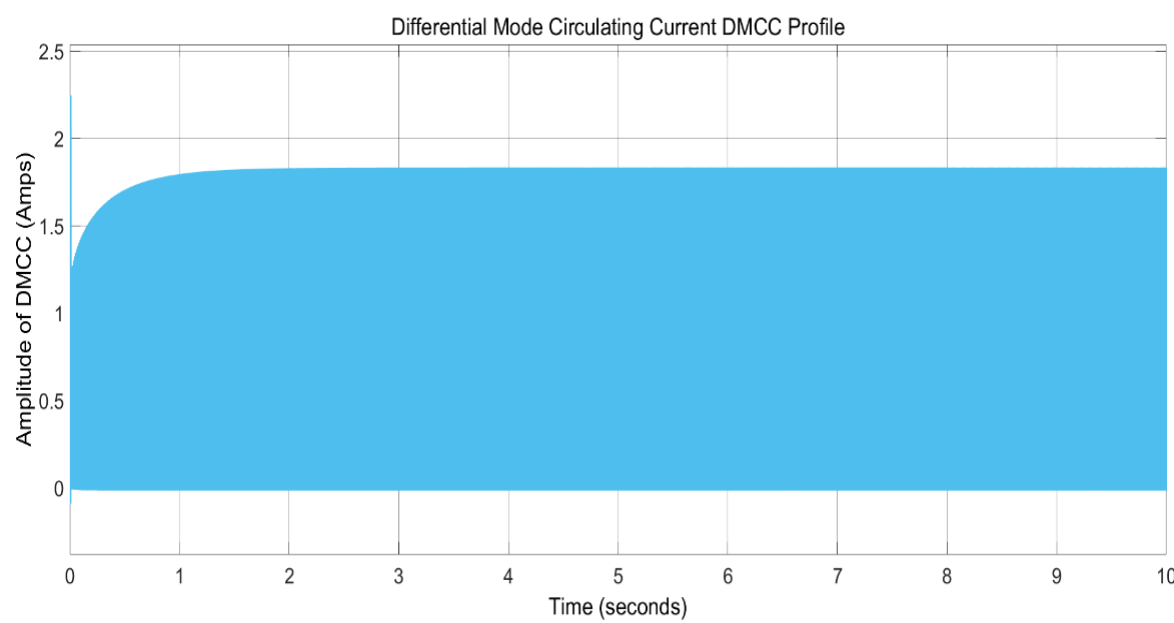
Figure 19. DMCC profile for two converters for AICMC controller.